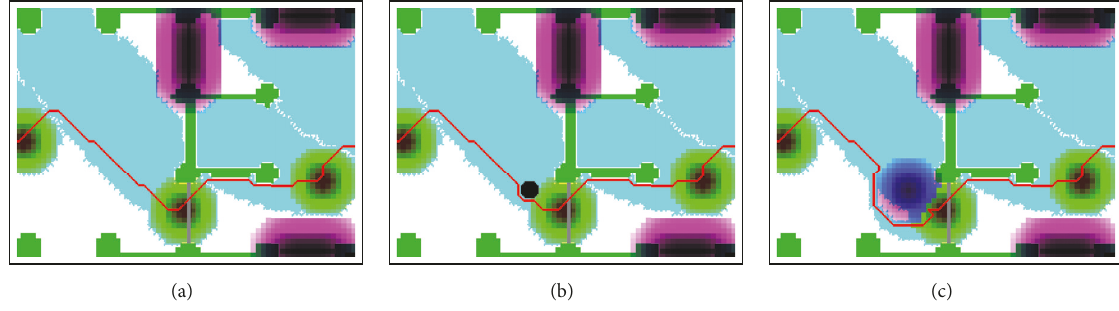
Figure 16: Close-ups of arena2 map of Dragon Age: Origins for A ∗ T: (a) without changing the influence field or search graph; (b) after removing a graph node and its 8 neighbors (in black); and (c) after adding two repulsors at the same location (in